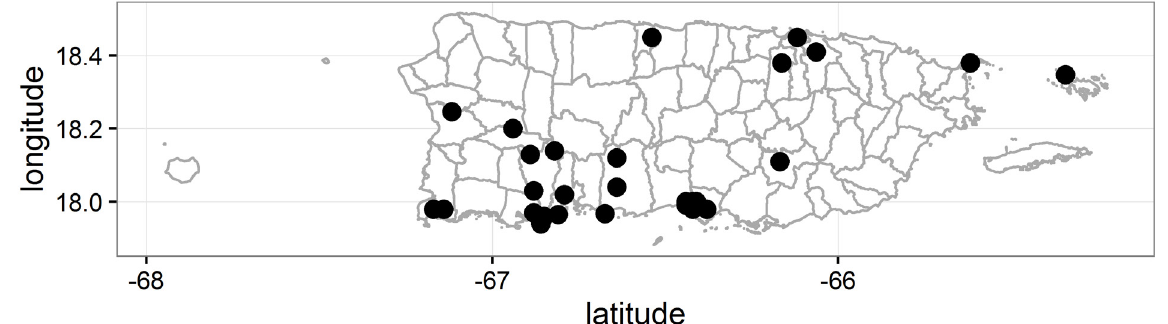
Fig. 5. Distribution map for Lasioglossum dispersum sp. nov. in Puerto